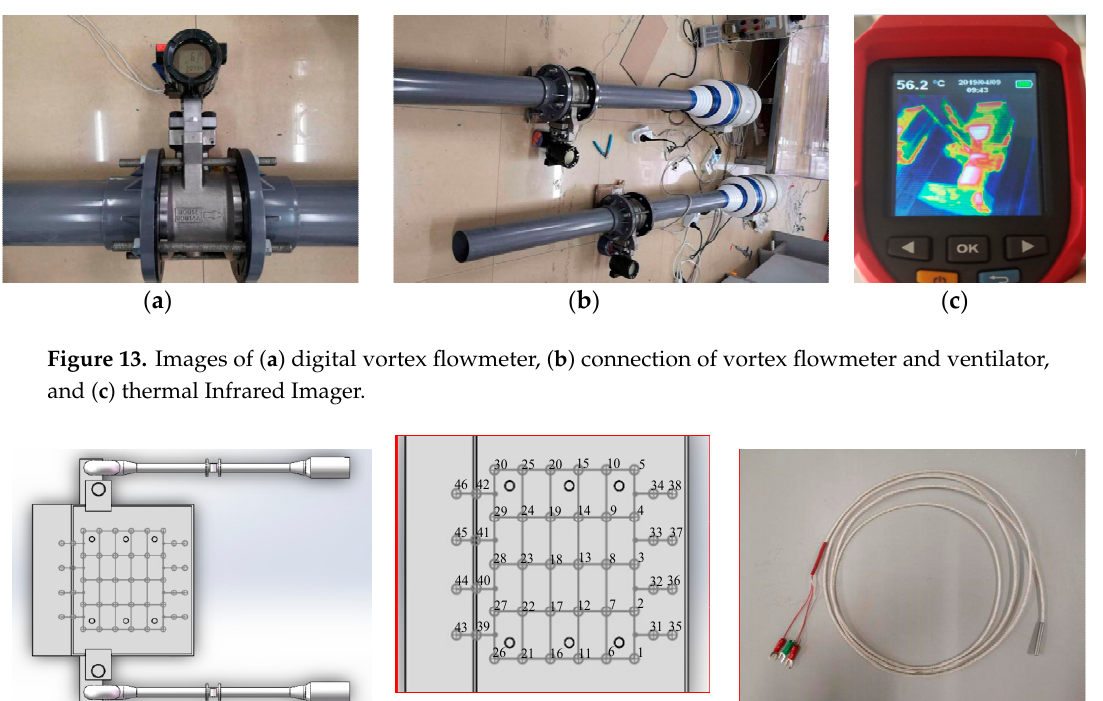
Figure 12. Images of ( a ) heating sources and engine models, ( b ) engine thermal pack, and ( c ) axial flow ventilator.